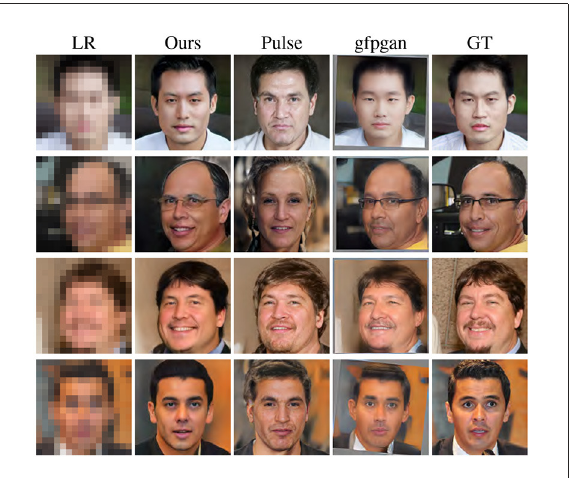
FIGURE8 Comparison of the image quality of the extreme FSR between ours, PULSE (Menon et al., 2020) and GFPGAN (Wang et al., 2021).